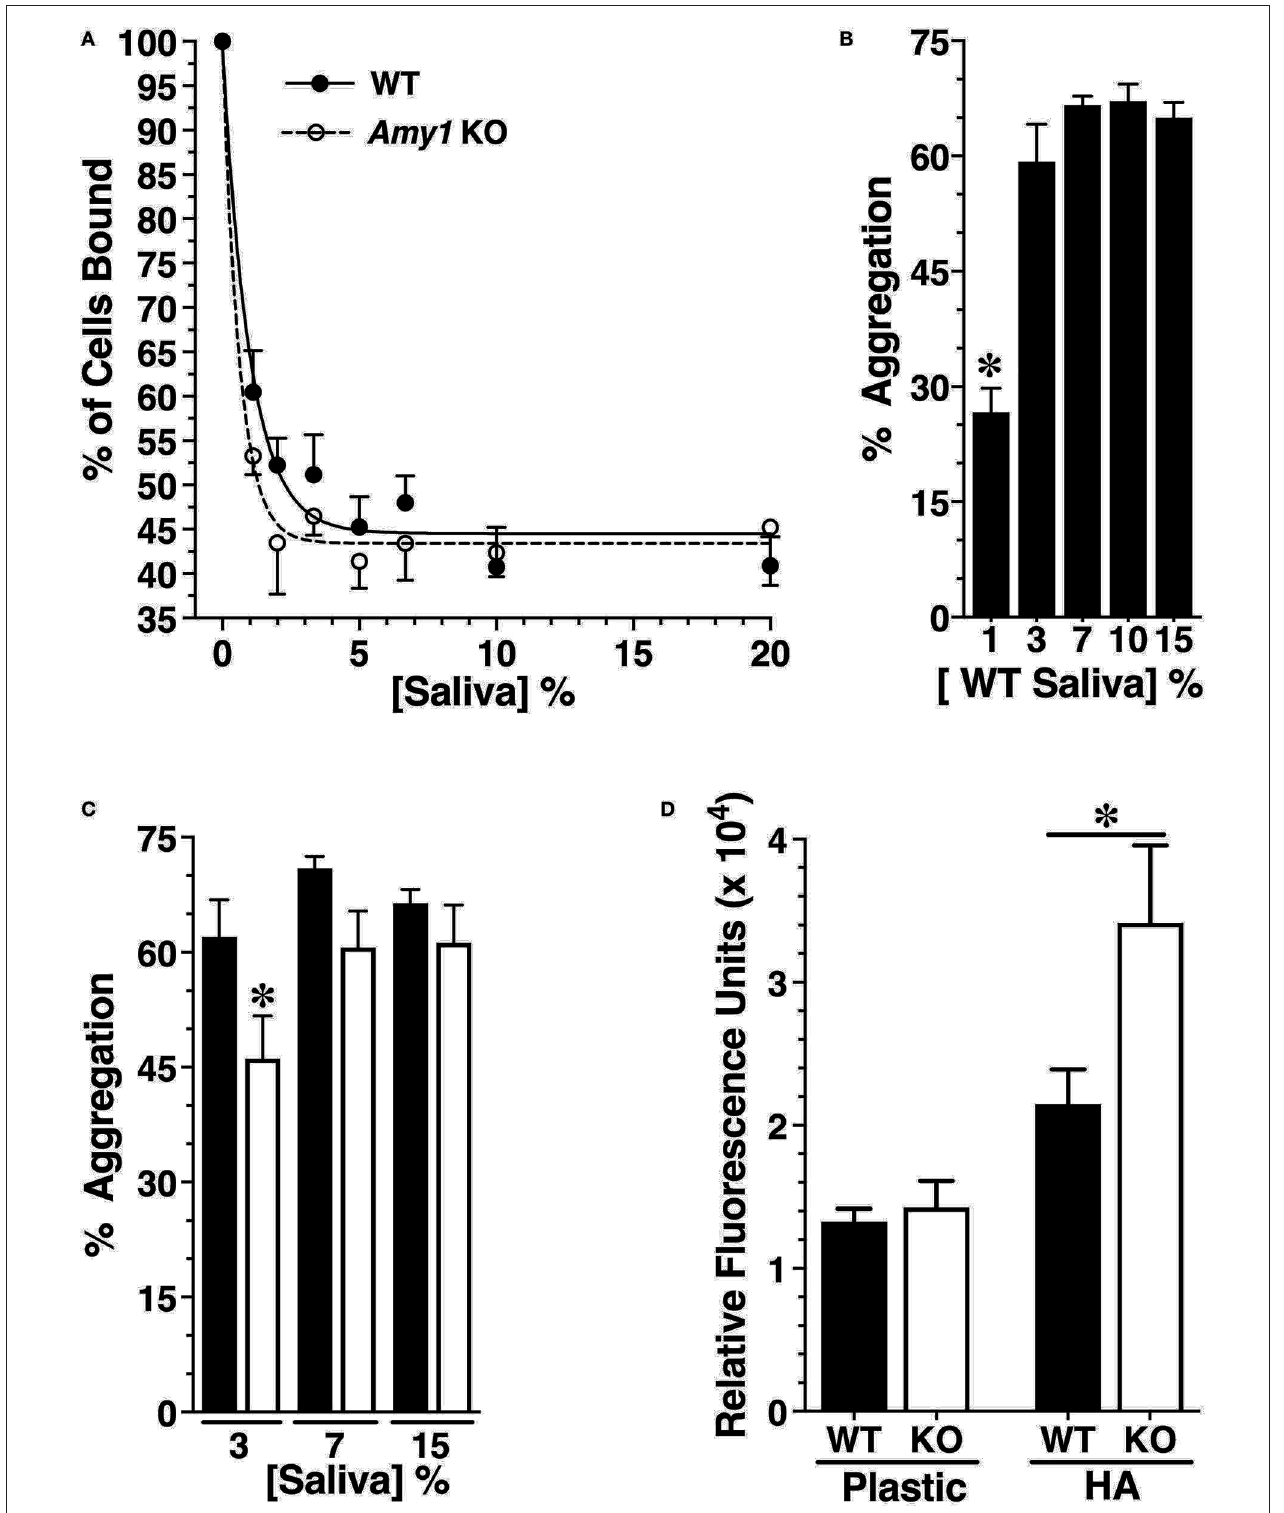
FIGURE 5 | Comparing innate immune functions in vitro between whole stimulated saliva from wild-type (WT) and Amy1 knockout (KO) mice. (A) Adherence of S. mutans to hydroxyapatite discs pretreated with increasing concentrations of whole stimulated saliva from WT and KO mice. Adherence is normalized to the percent of cells bound in the absence of saliva. Values are mean ± SE from five separate experiments. P > 0.05 for all comparisons between WT and KO at each concentration